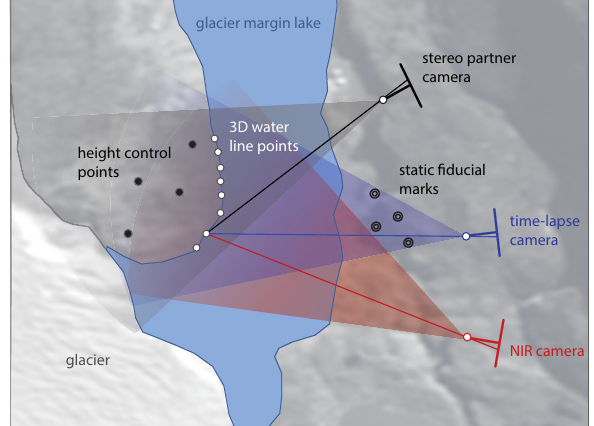
Figure 3. Schematic delineation of the measurement configuration at Lago Cachet